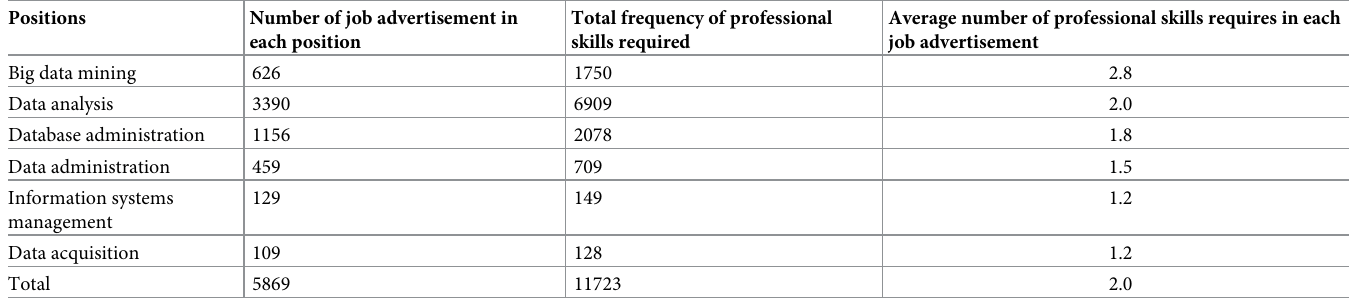
Table 4. Statistics of skills in each position.